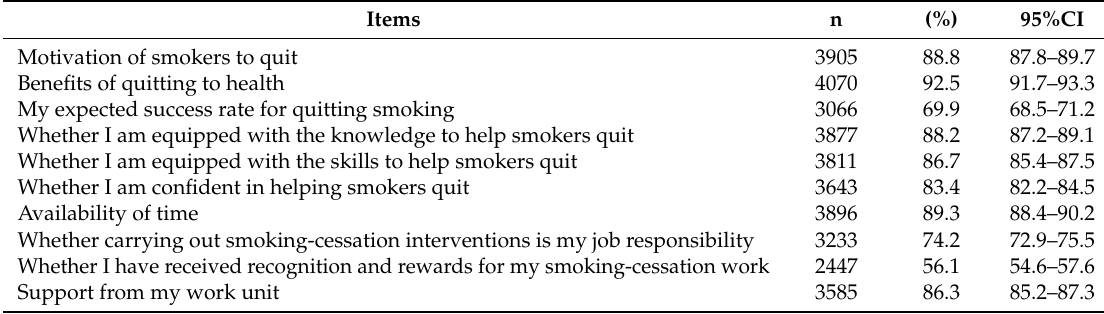
Table 7. Determinants of nurses’ participation in smoking-cessation interventions (N = 4413) #